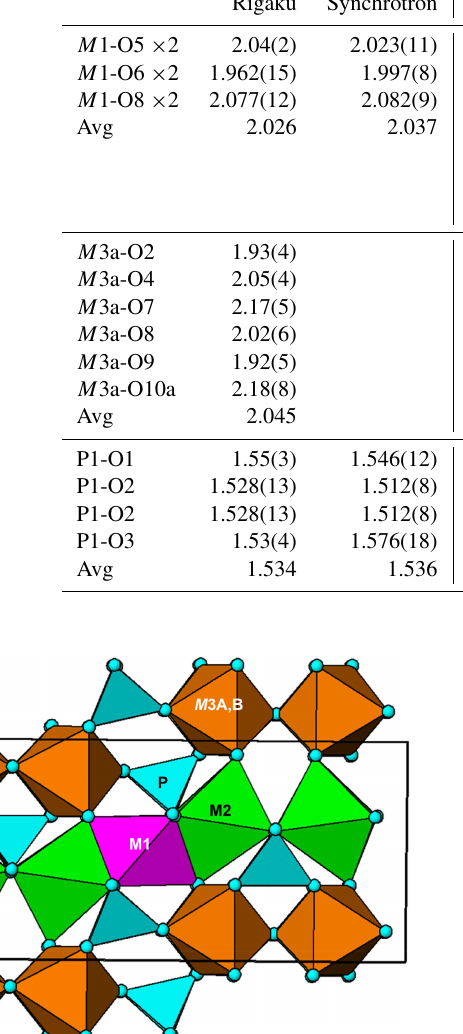
Table 6. Polyhedral bond distances in manganrockbridgeite. Rigaku Synchrotron Rigaku